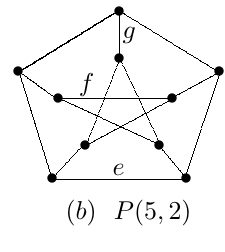
Fig. 1. Two graphs with order 10 Figure 1. Two graphs with order